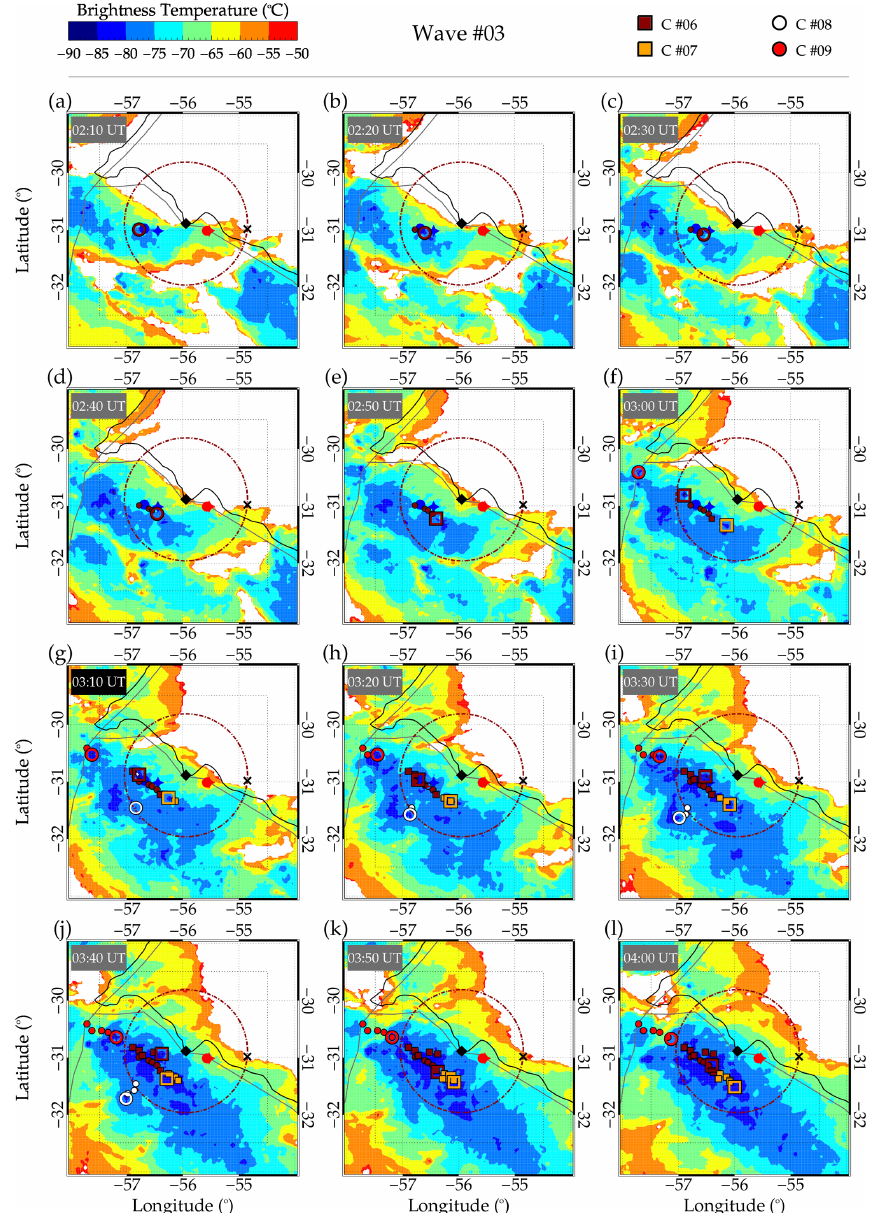
Figure 12. Tracking of the individual convective cores (Cs), C no. 06, C no. 07, C no. 08, and C no. 09, in space and time for Wave no.